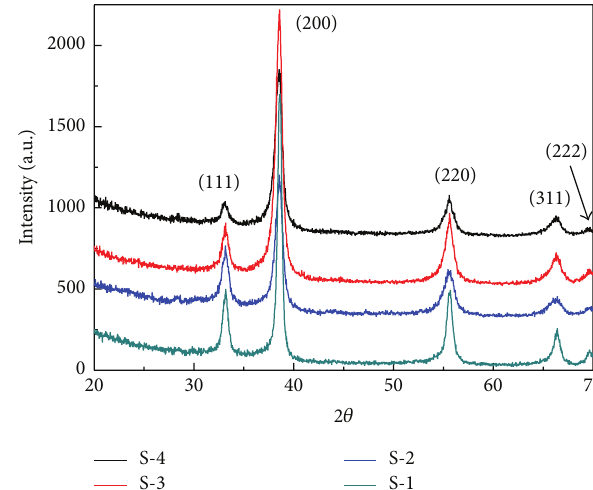
Figure 1: X-ray diffraction patterns of the Al-doped CdO films of S-1, S-2, S-3, and S-4 groups.